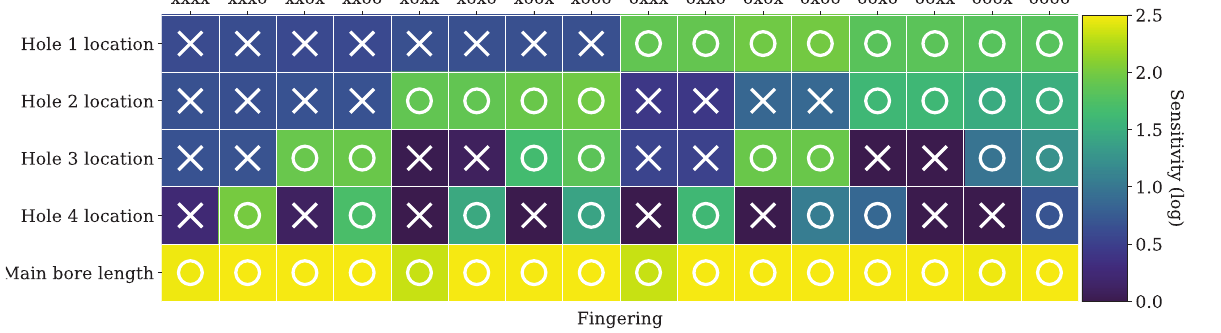
Figure 5. Sensitivity of the re fl ection coef fi cient w.r.t the hole locations/bore length design parameters (Eq. (34)) for frequencies in [0.1, 4] kHz with a 2 Hz step. Open (resp. closed) holes are indicated with circles (resp. crosses).